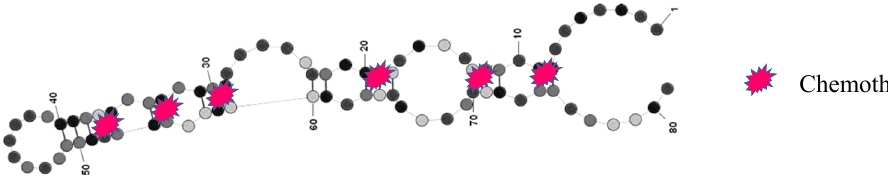
Figure 3. Schematic representation of non-covalent aptamer-drug complexes. Drugs are intercalated within the aptamer sequences.